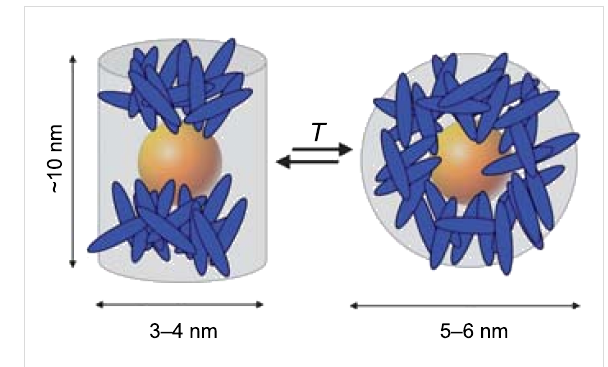
Figure 11: Reversible migration of the surface ligands as a function of temperature (and phase). Only the blue mesogenic ligands are depicted in this image. Reprinted with permission from [64]. Copyright 2010 Wiley-VCH